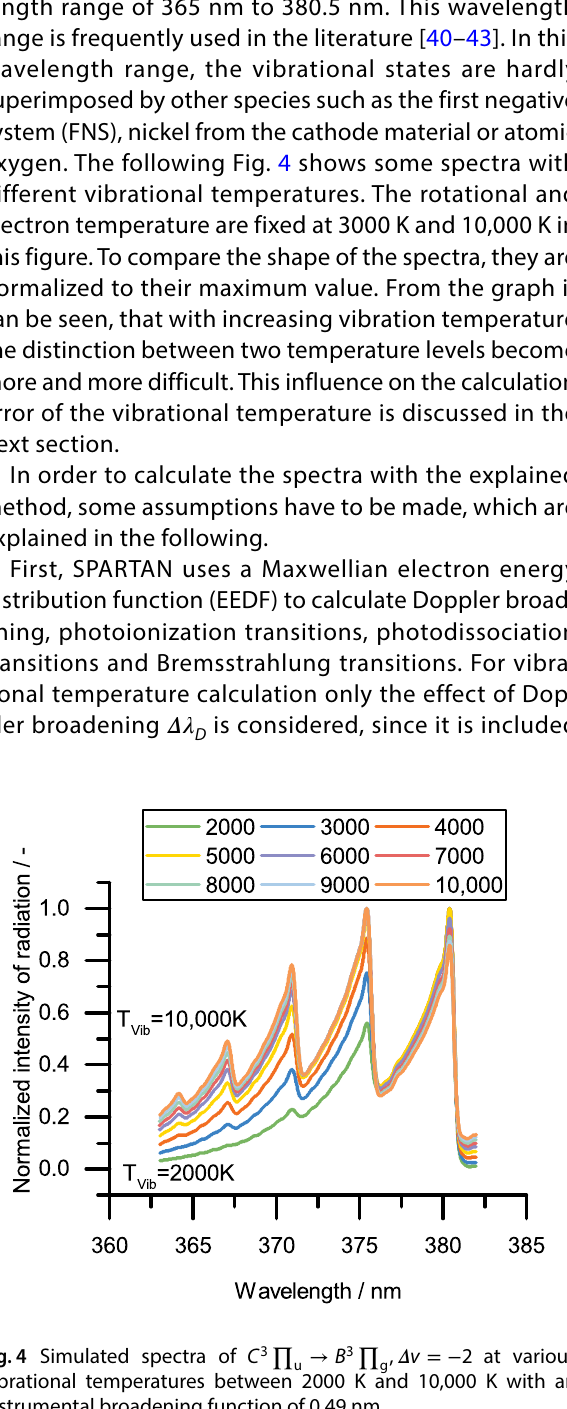
Fig. 4 Simulated spectra of C 3 vibrational temperatures between 2000 K and 10,000 K with an instrumental broadening function of 0.49